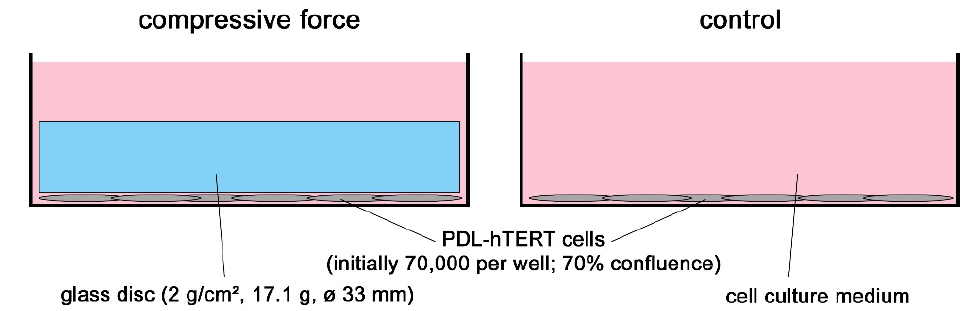
Figure 1. In vitro model for compressive mechanical strain on PDL-hTERT cells. Compressive force is applied by sterile glass disks (17.1 g, 2 g / cm 2 ) onto PDL-hTERT cells growing adherently in 6 well cell culture plates under standard cell culture conditions in rich medium. Cells without glass disks serve as controls. Cells are incubated for di ff erent time spans and the amounts of analytes are referenced to the start of experiments (T = 0 h) and to each respective control (T = 6 h, 24 h, 48 h and 72 h).